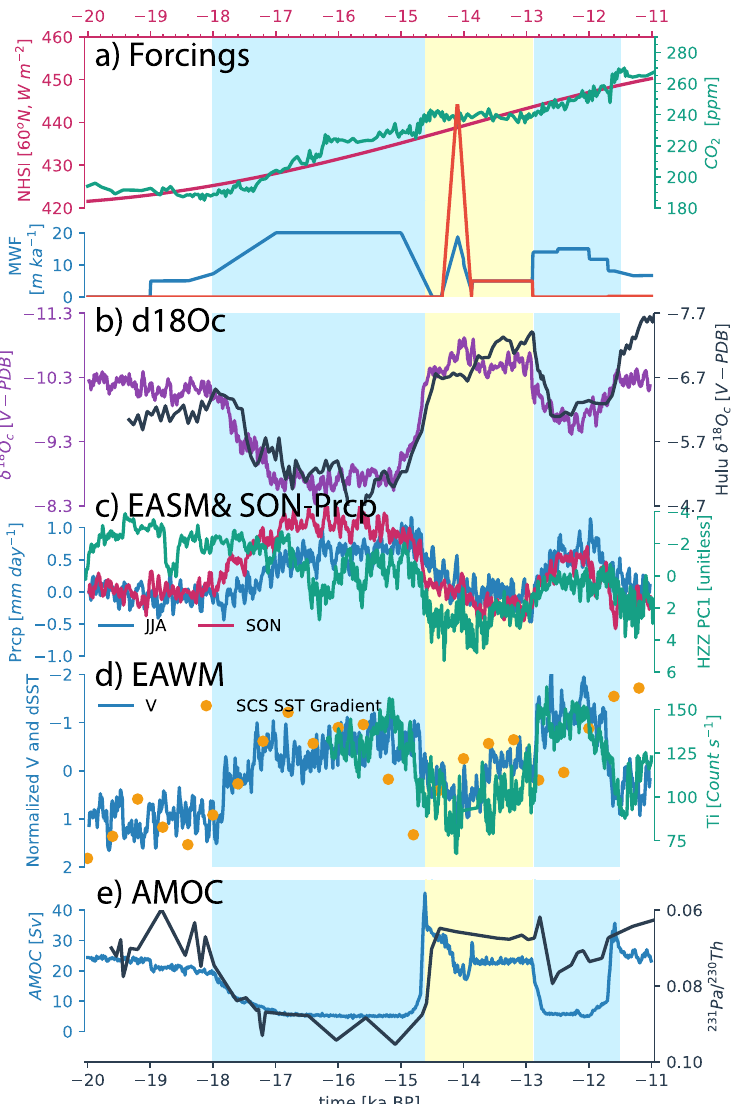
Fig. 1 Deglacial evolution of East Asian monsoon in iTRACE and paleoclimate proxy. a Forcing: June insolation at 60°N (red), atmospheric CO 2 concentration (green), and meltwater fl uxes in the Northern Hemisphere (blue) and Southern Hemisphere (orange); b cave δ 18 O c in iTRACE (purple) and observation (black) at Hulu cave 10 ; c South China [20 – 35°N, 108 – 120°E] summer (blue) and autumn (red) precipitation and the leading PC of Mg/Ca, Sr/ Ca, and Ba/Ca records observed in Haozhu 9 , a proxy for South China monsoon precipitation (green); d EAWM index (blue) in iTRACE, SCS SST-gradient index (dots) 13 , and sediment Ti content (green) from Lake Huguang Maar 4 , proxies for EAWM; e simulated AMOC intensity (blue) and observed 231 Pa/ 230 Th in sediment core GGC5 as a proxy for AMOC intensity (black) 11 . In c , the ice sheet and ocean bathymetry effect is removed in autumn precipitation (see supplementary). In d the EAWM index is de fi ned as region average [20 – 35°N, 108 – 130°E] of the near-surface (925-1000hPa) meridional wind. The SST gradient and EAWM index are normalized for